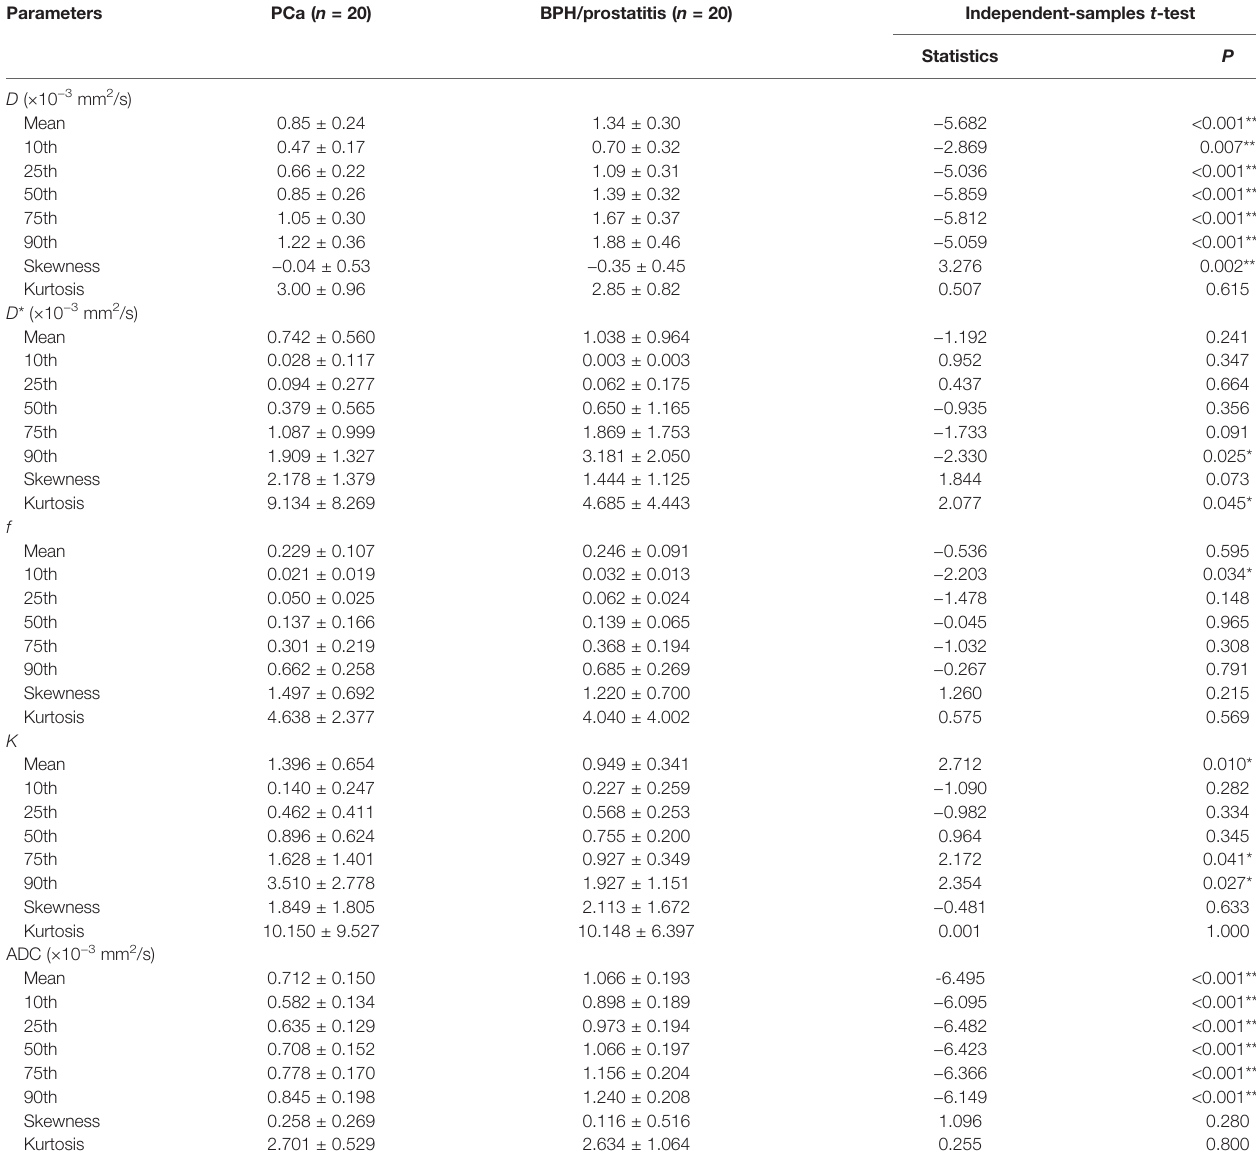
TABLE 3 | The mean values and histogram parameters for D (×10 − 3 mm 2 /s), D * (×10 − 3 mm 2 /s), f , K , and ADC (×10 − 3 mm 2 /s) in PCa and BPH/prostatitis.